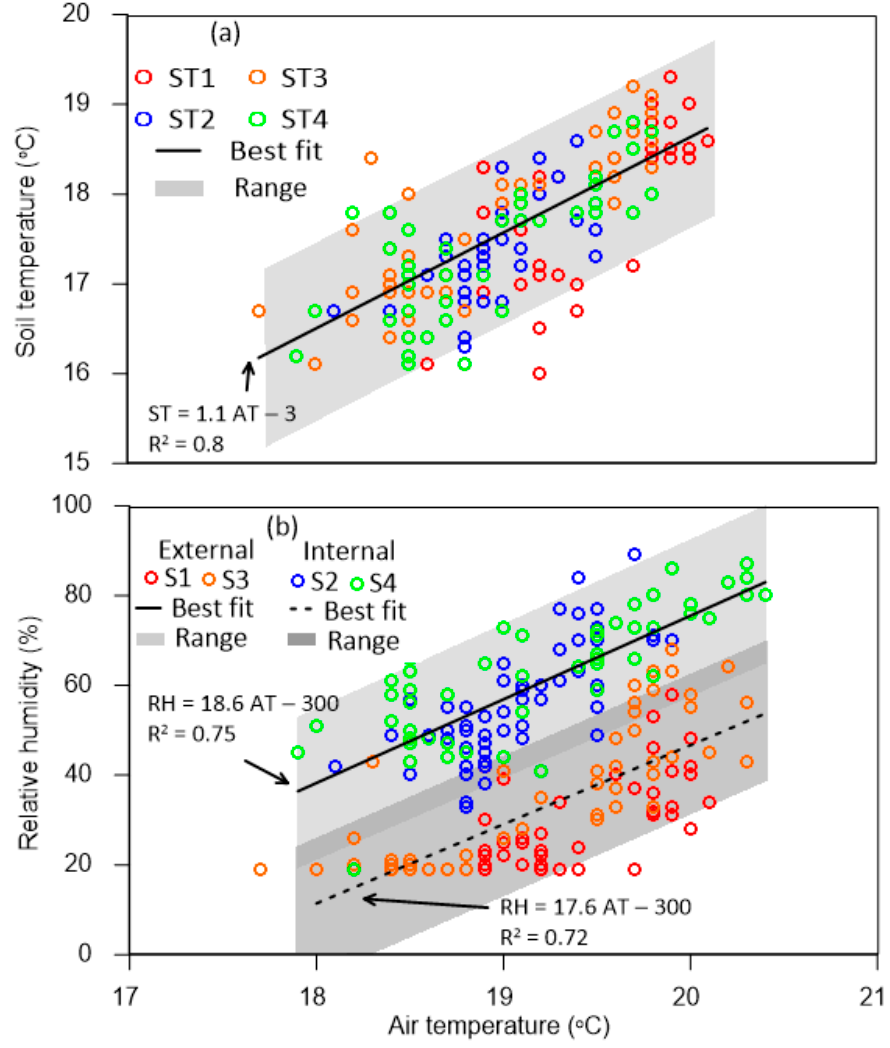
Figure 6. Correlation of measured air temperature during shrinkage in the large cell ( a ) with soil temperature and ( b ) with relative humidity.